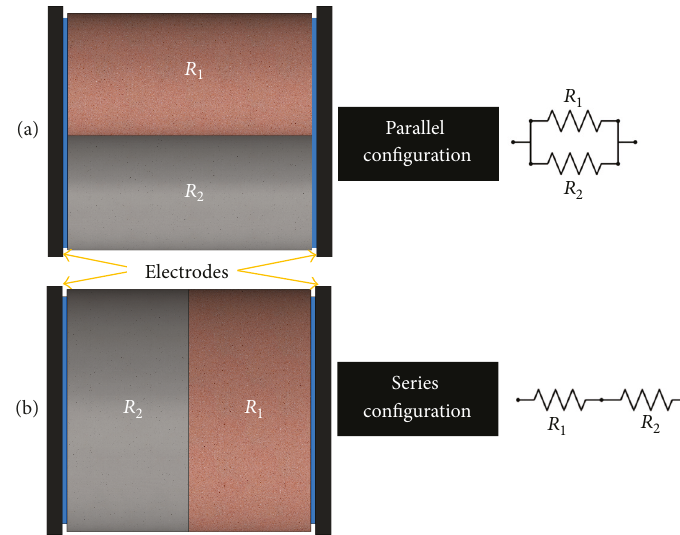
Figure 14: Schematic of the (a) parallel and (b) series models of heterogeneous systems (reproduced from [21]).